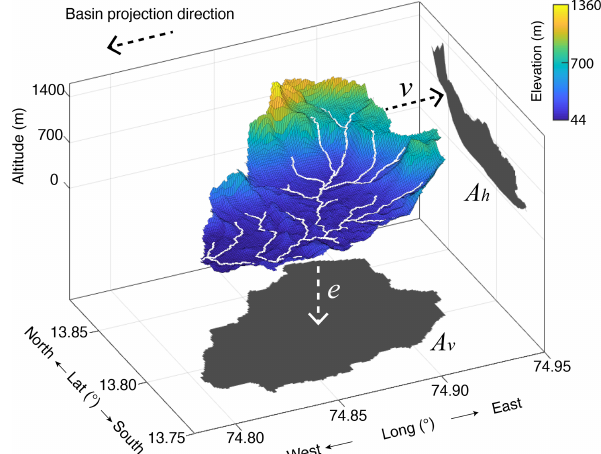
Figure 6. Depiction of the flux of mass through the surface of a drainage basin from the coastal escarpment of the Western Ghats, India. Basin position is indicated as basin D in Fig. 2. Spatial sur- face of drainage basin and its projection in the vertical and a hori- zontal direction. Projected areas are A v and A h , respectively. Thick white lines denote channels extracted from the DEM for a minimum drainage area of 1km 2